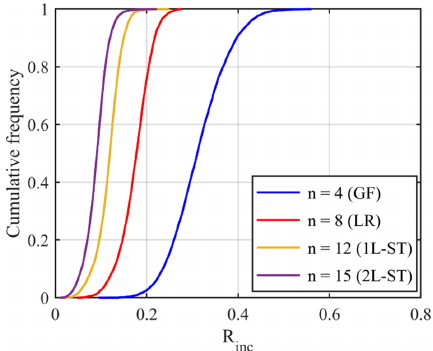
Figure 6. Cumulative distribution of R inc at different RLS for 4155 LBS particles.